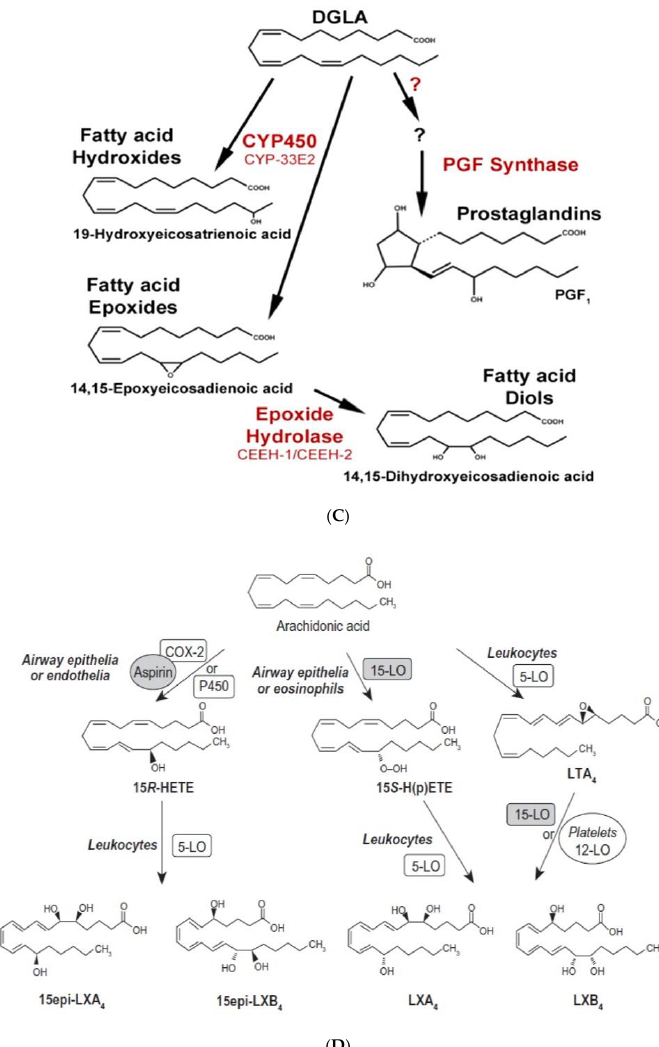
Figure 2. ( A ) Scheme showing metabolism of essential fatty acids and their important products. ( B ) Scheme showing metabolism of AA, eicosapentaenoic acid (EPA) and docosahexaenoic acid (DHA) by cytochrome P450 enzymes. DHA, alpha-linolenic acid (ALA), LXA4 and possibly, other bioactive lipids (BALs) may inhibit sEH enzyme and thus, bring about